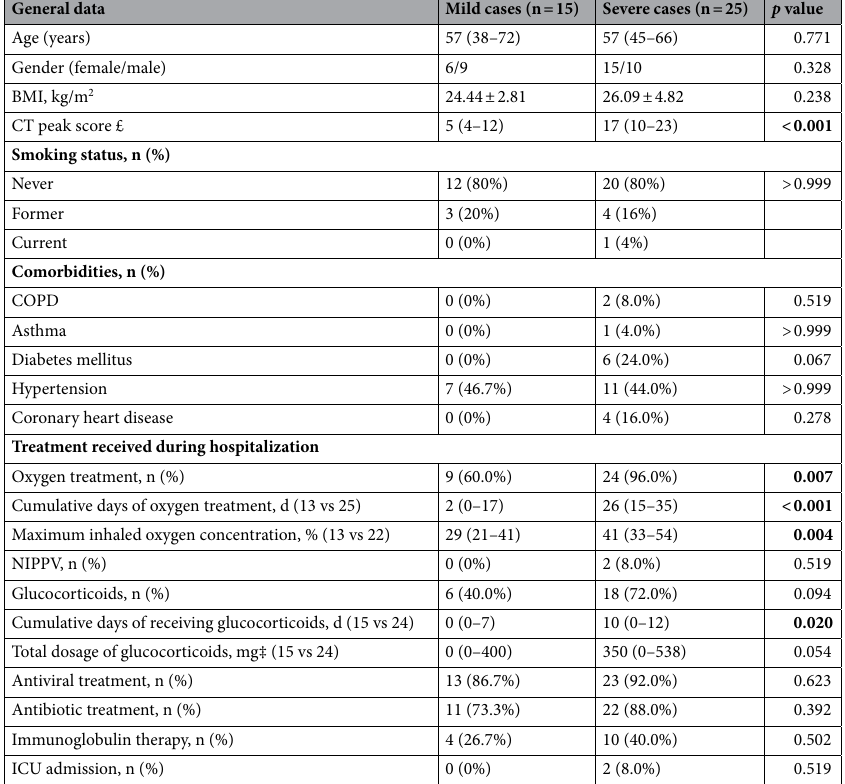
Table 1. Demography and treatment of participants by the severity of COVID-19. Data were expressed as mean ± SD, median (interquartile range), or No. (%). Comparisons were determined by Student’s t-test, Mann– Whitney U test or Fisher exact tests as appropriate. The actual number of cases was marked behind each index, when there was missing data. BMI body mass index at eight months after discharge, COPD chronic obstructive pulmonary disease, NIPPV , noninvasive positive presure ventilation, ICU intensive care unit. £ The CT peak score during hospitalization of one patient with severe COVID-19 was missing. ‡ Total dosage of glucocorticoid means accumulative dosage of glucocorticoid converted to prednisone for COVID-19